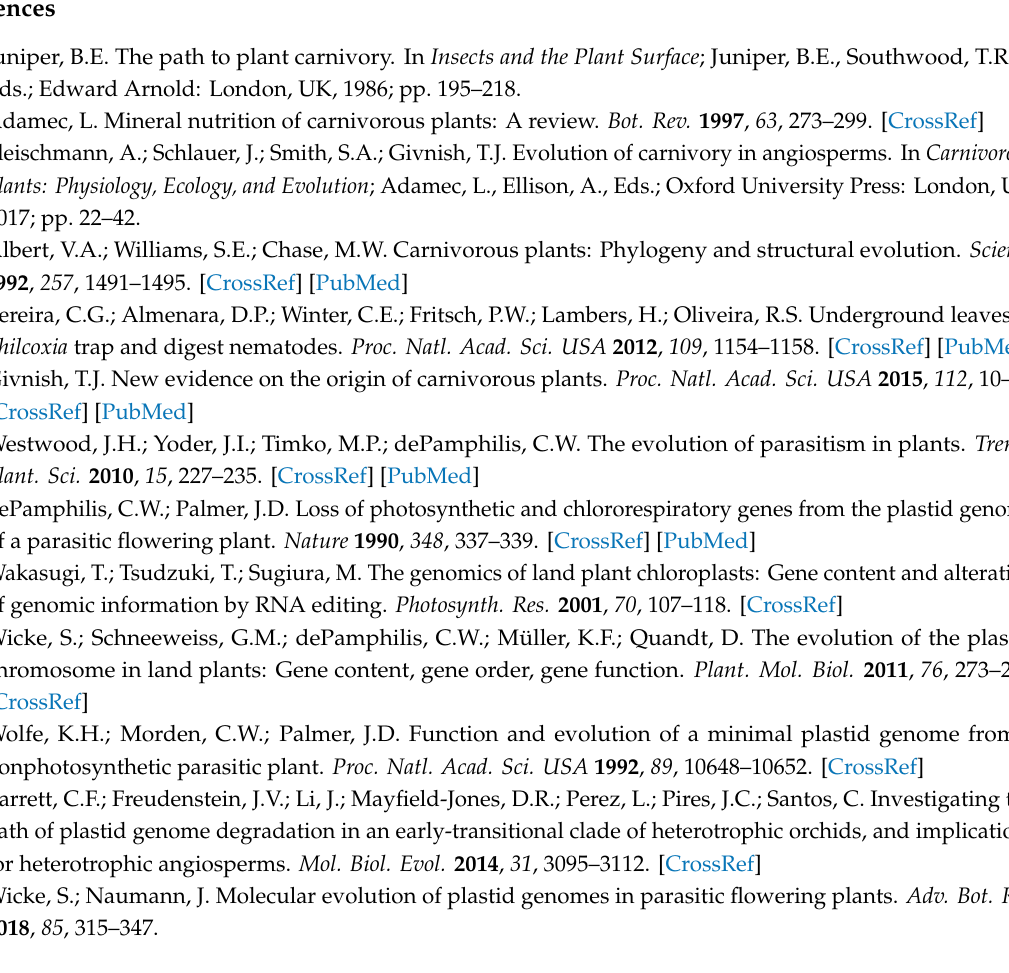
plastome. Table S2: RNA-editing pattern in N. × ventrata plastome predicted by PREP-Cp and identified by RNAseq read alignment. Table S3: RNA-editing pattern in D. rotundifolia plastome predicted by PREP-Cp. Table S4: Repeat regions in plastidial rps18 genes. Table S5: Primers used for D. rotundifolia plastome